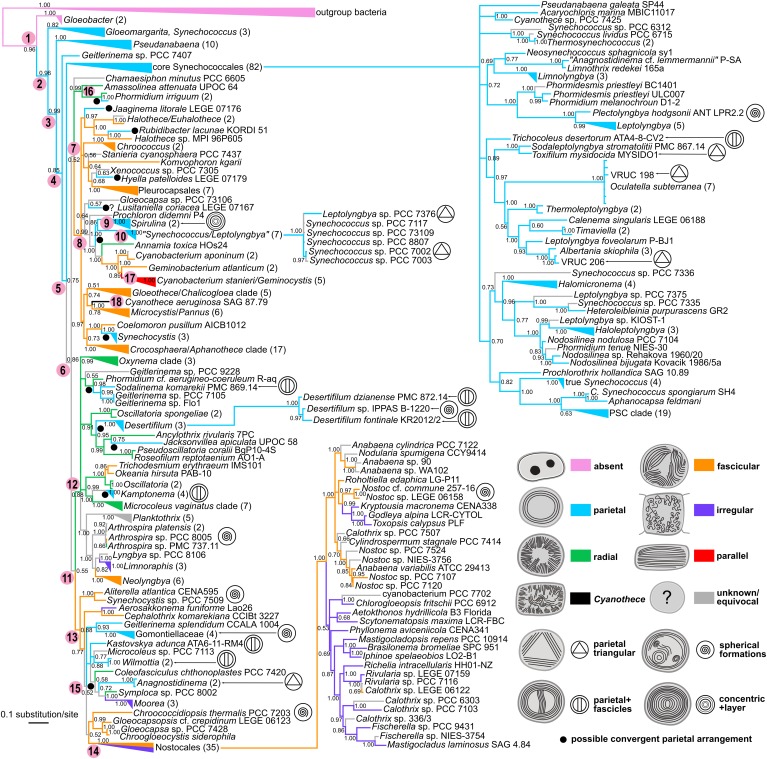
Phylogenetic tree of cyanobacteria inferred from the SSU rRNA gene with traced evolution of thylakoid arrangement. The tree was calculated using BI from an alignment of 298 sequences spanning 1477 nucleotide positions. Estimated posterior probabilities are displayed near the nodes. Numbers in parentheses represent the number of sequences in collapsed branches. Color-coded thylakoid arrangements in non-terminal nodes were inferred using the parsimony ancestral reconstruction method. Special features in thylakoid architecture are indicated with pictograms. Reconstructed convergent occurrences of the parietal arrangement are marked with filled black circles. Selected nodes, which are referred to in the main text, are numbered to facilitate tree description. Collapsed nodes containing taxa with a single category of thylakoid arrangement together with taxa with unknown ultrastructure are color-coded according to the known category. PSC clade = Prochlorococcus, marine Synechococcus, and Cyanobium.